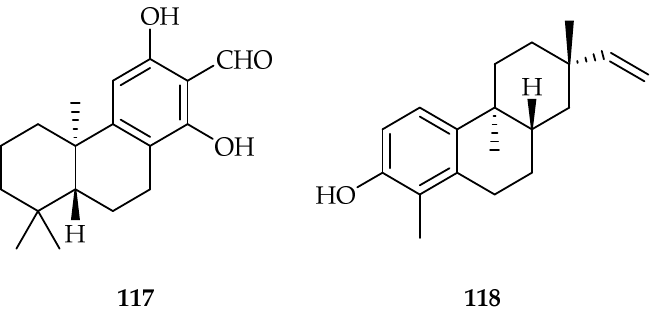
Figure 48. Structures of euphorfischerin A 117 [72] and euphorfischerin B 118 [72].